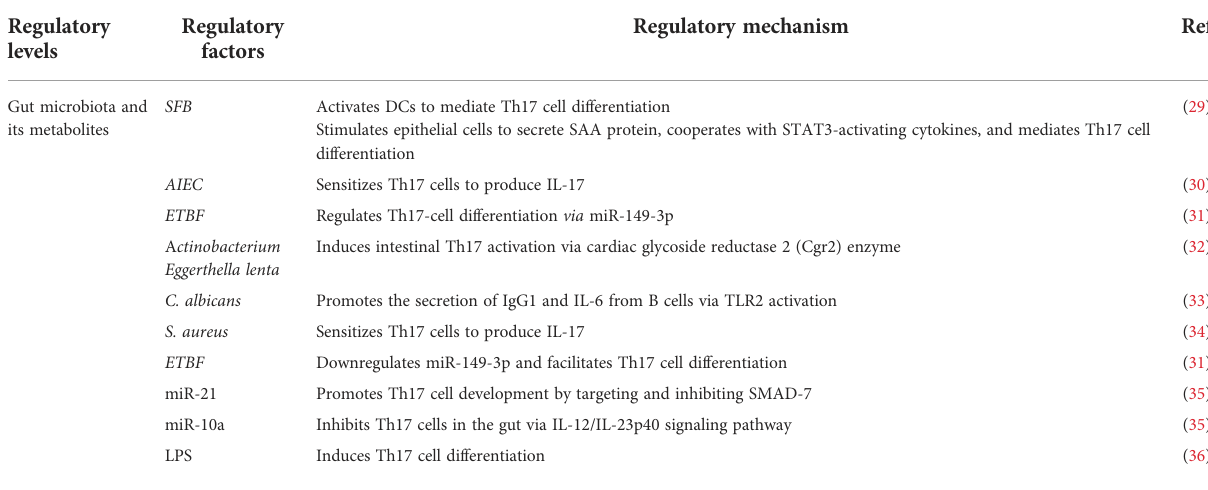
TABLE 1 Regulation of Th17